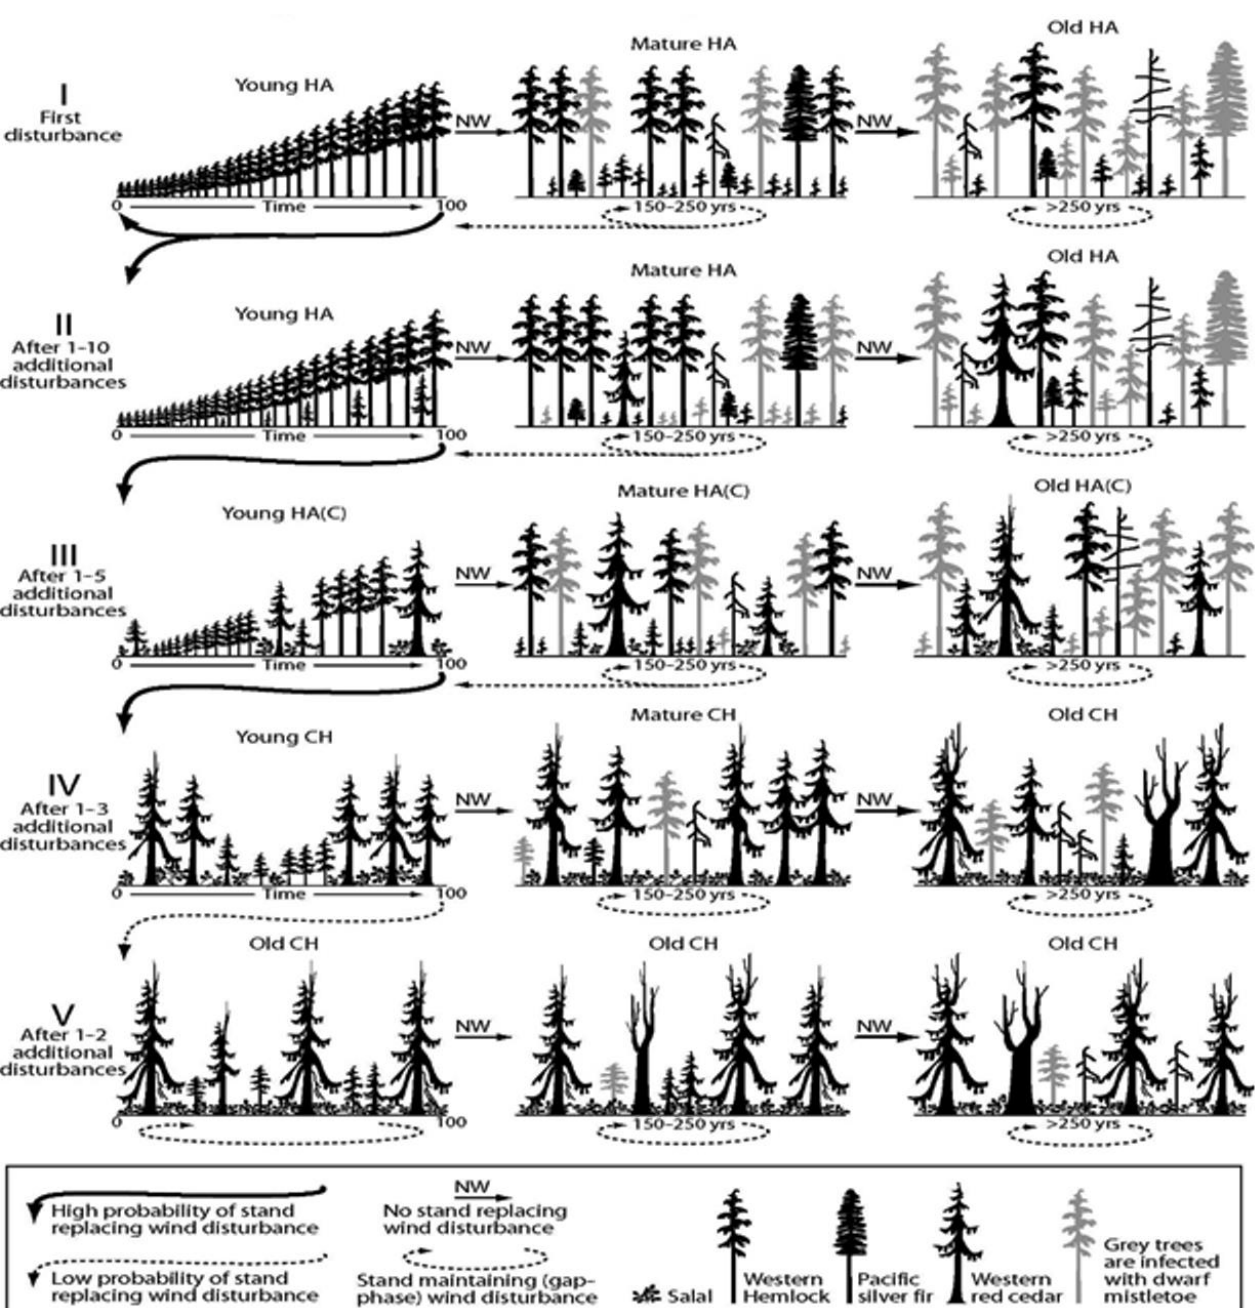
Figure 4. Alternative, multiple-pathway succession process proposed by [26] for zonal sites on northern Vancouver Island. Adapted with permission from Ref [41]. (c) 2004 Prentice Hall. Table 1. Ecological stages (stand types by stand age) in which the forest can be in a given time.